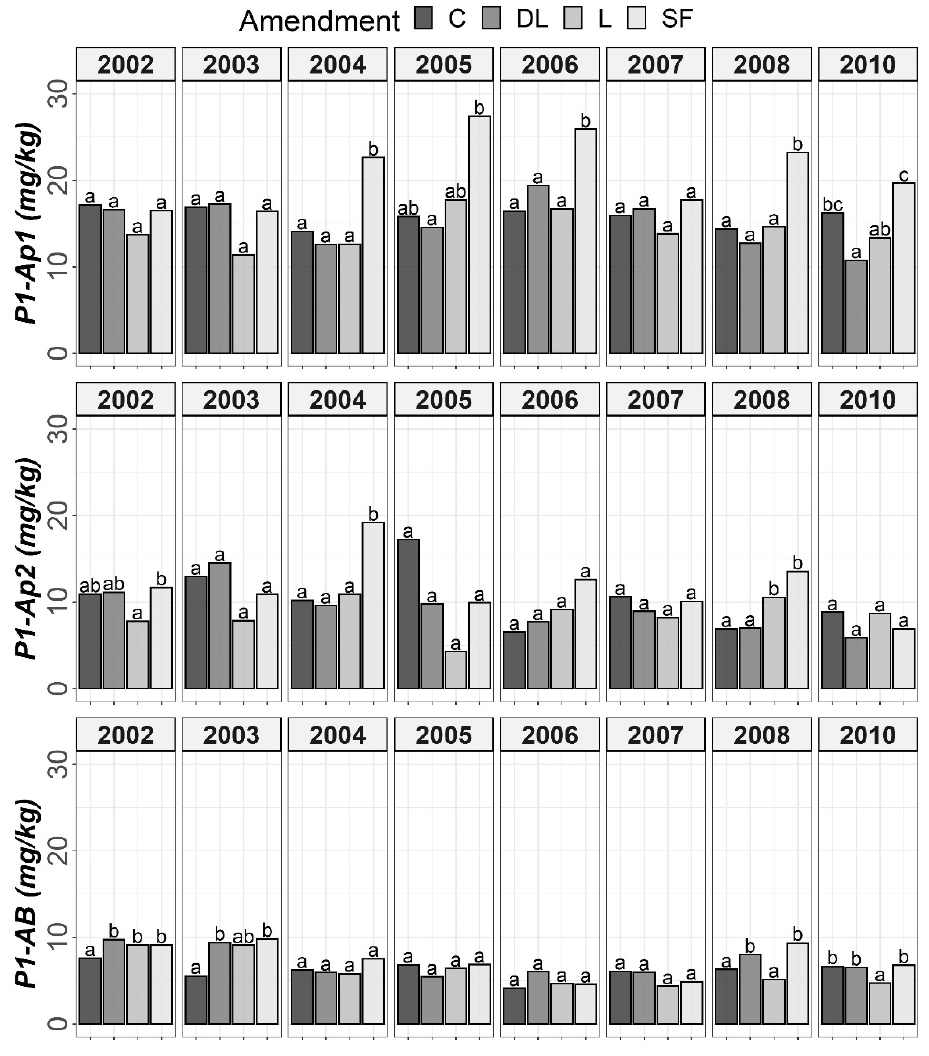
Figure 2. Temporal evolution of Bray-1’s phosphorus (P1) in the three horizons (Ap1, Ap2 and AB) studied throughout the soil monitoring period (2002–2010). Bars within each year and horizon fol- lowed by different lowercase letters reflect significantly different averages according to Tukey’s honest significance test with Holm–Bonferroni adjustment ( p = 0.05).